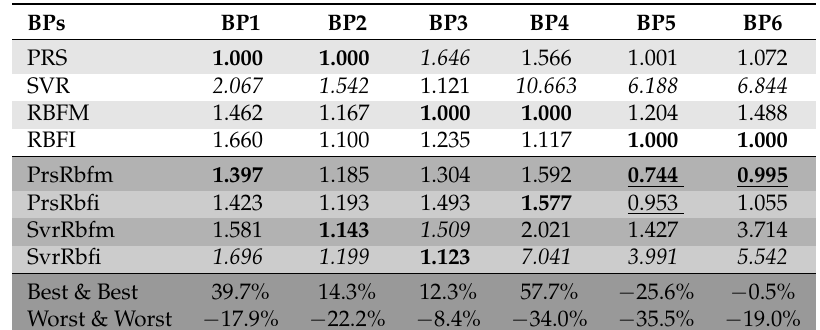
Table 4. Normalized standard deviations of RMSE of the metamodels for each benchmark problem ( k + 1 )( k + 2 ) with 3 training points. 2 BPs BP1